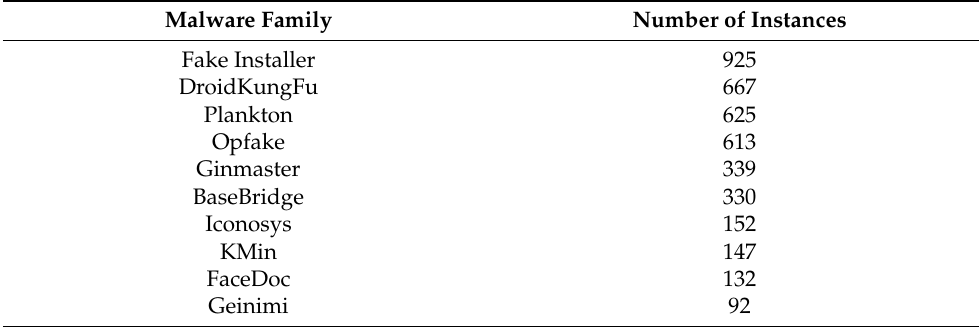
Table 2. Top 10 malware families in the Drebin